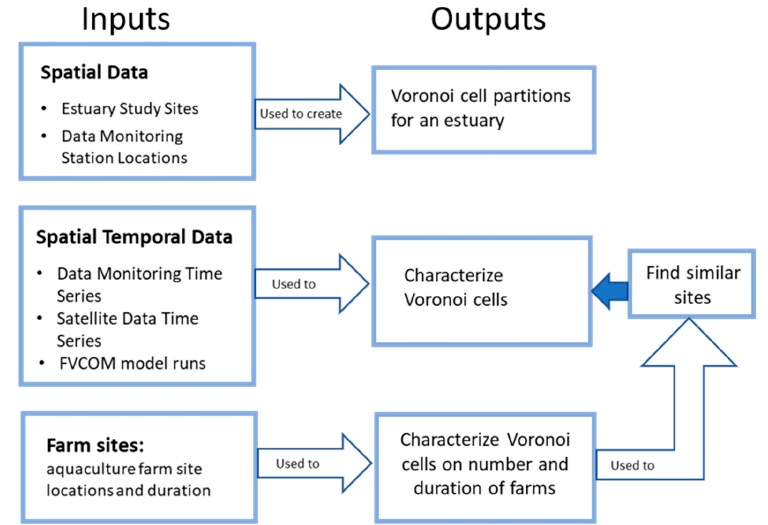
Figure 1. ( a ) The distribution of aquaculture license (LPA) and ( b ) distribution of lease sites along the Maine coast as of 2019. Basemaps from Bing maps © 2020 Microsoft.